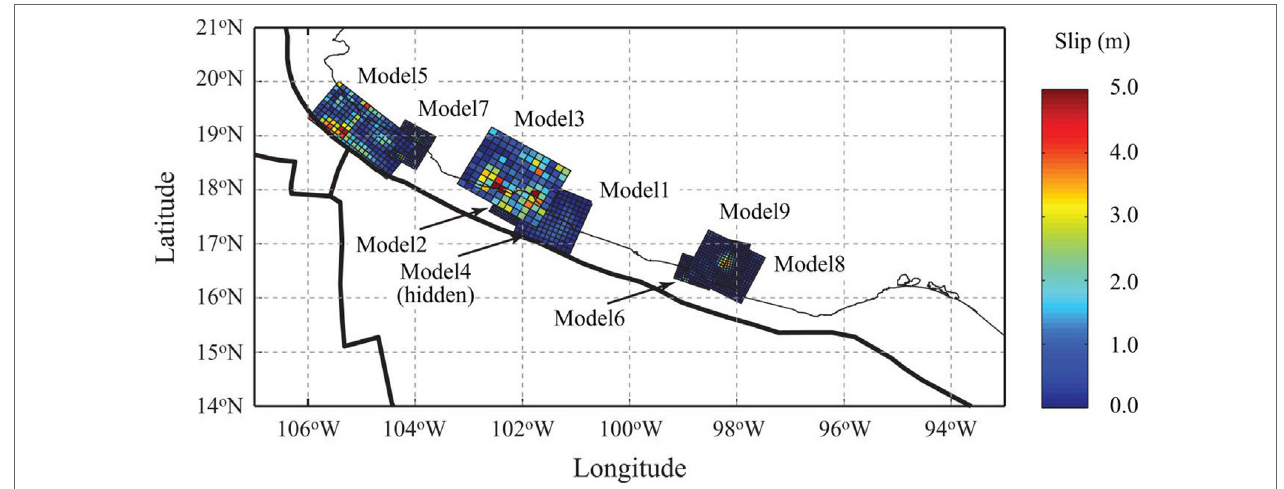
FigUre 1 | Finite-fault models, along the Mexican Pacific coastline, available in the SRCMOD database (see details of parameters in Table 1